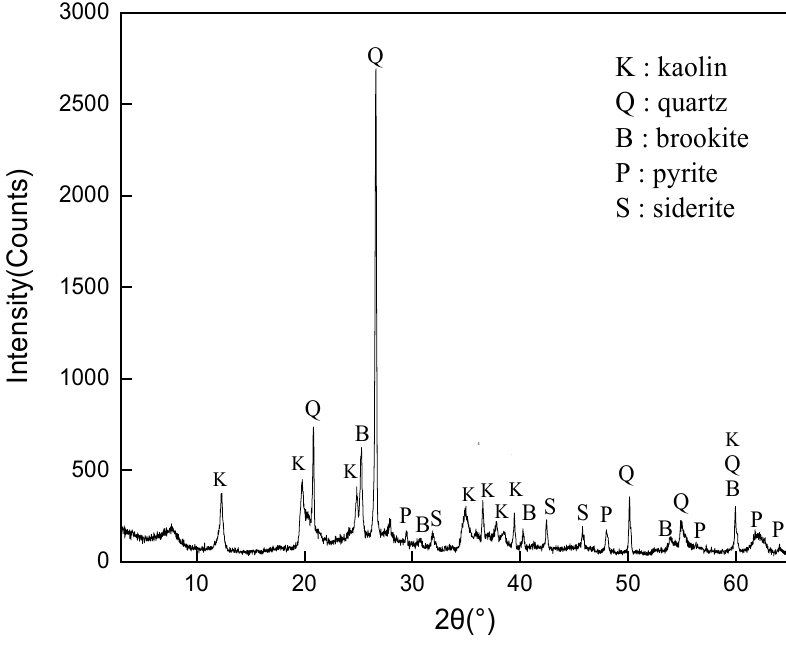
Figure 2. XRD spectrum of coal gangue.